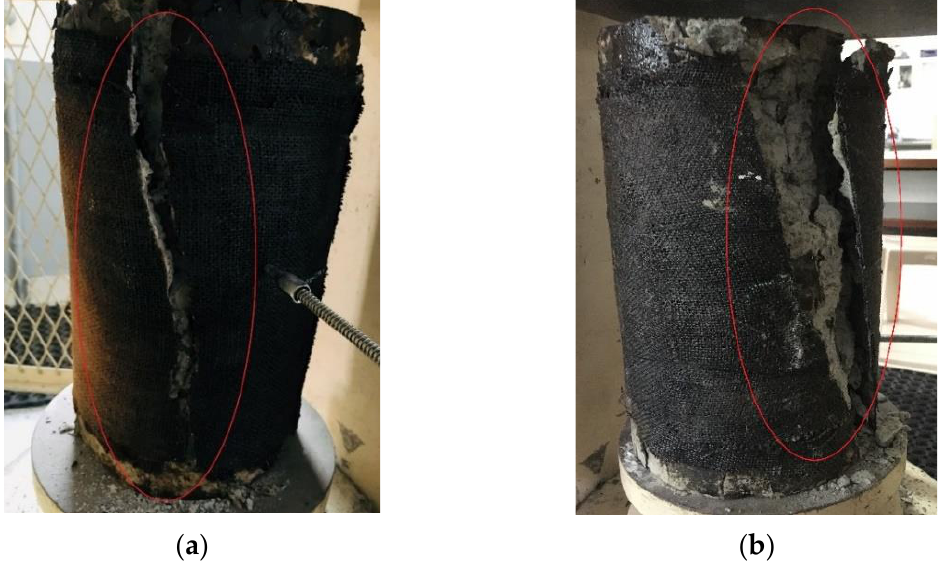
Figure 7. Failure patterns of confined SFRP specimens exposed to elevated temperature: ( a ) C- E0C2S400; and ( b ) C-E1C2S400.